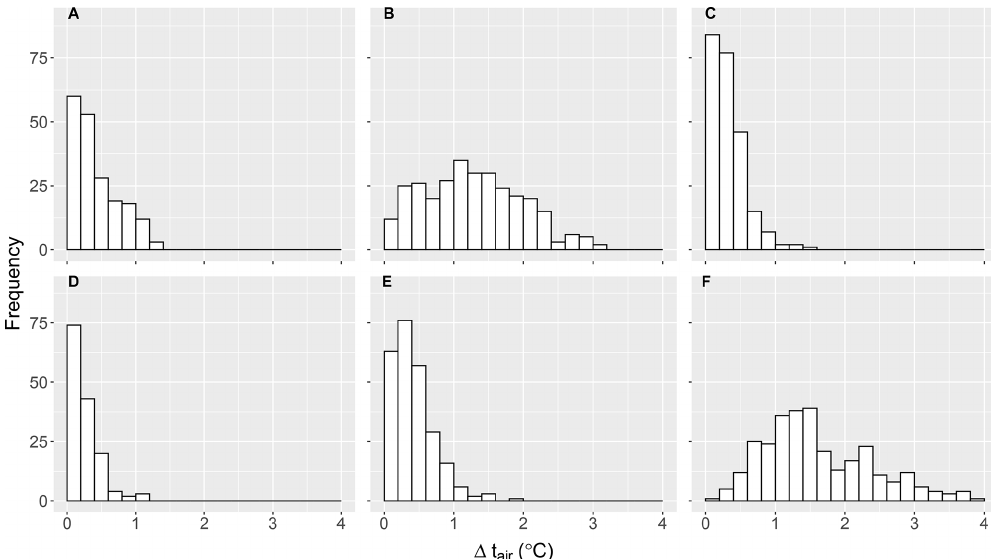
Figure 11. Results of the evaluation of (cid:49)t air for each pair of sensors. System types are identified with letters (from A to F; refer to Table 1 for identification). The histogram is divided in bins of 0.2 ◦ C, and the number of occurrences of (cid:49)t air is shown for each instrument.